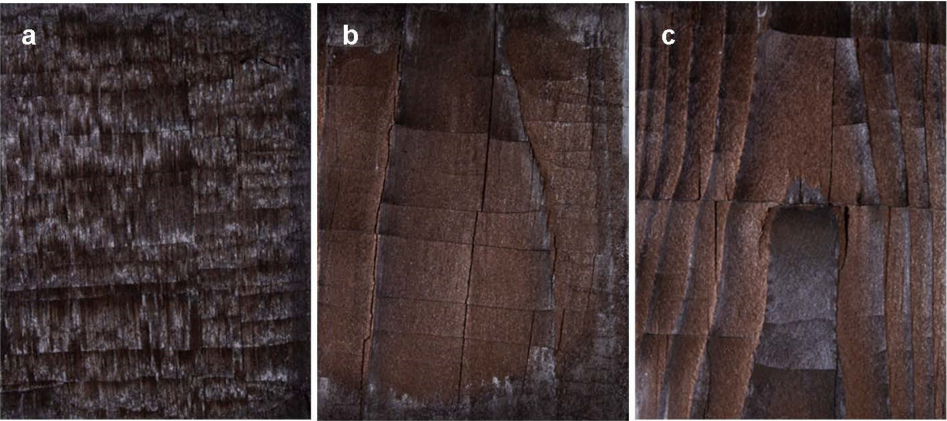
Figure 6. Detailed images of weathered surfaces: B60 ( a ); LS60 ( b ); DS60 ( c ).